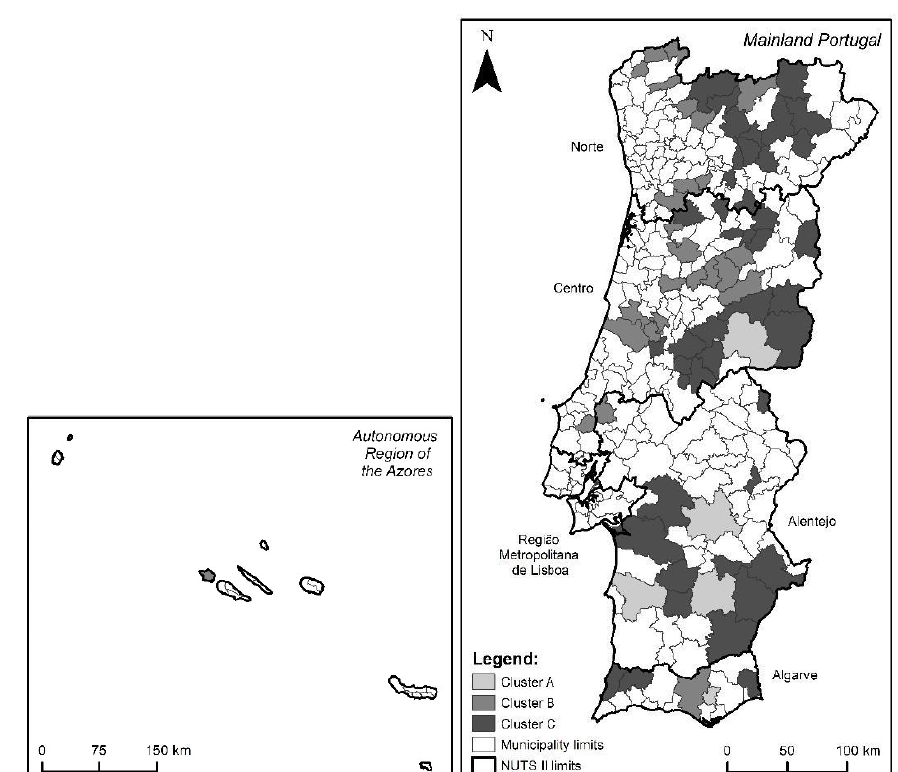
Figure 1. Geographical distribution of the municipalities in the sample according to the three clusters; our own elaboration. (Note: the autonomous region of Madeira is purposely not included in this graph, as it contained no PR municipalities in our sample).